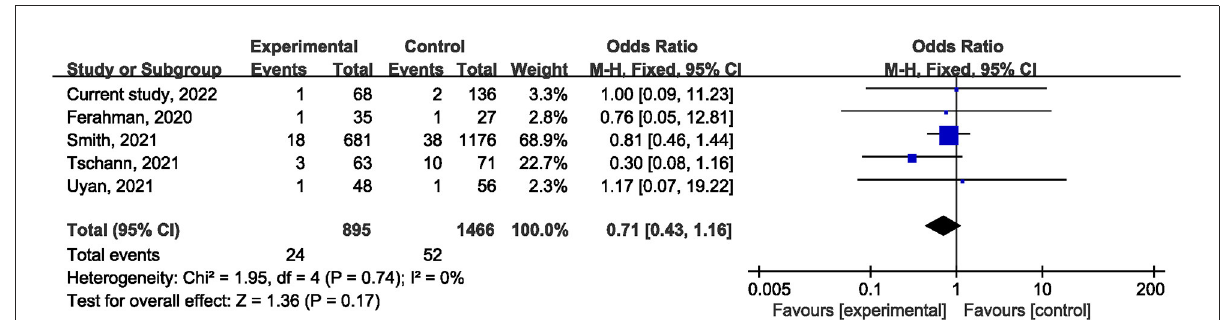
chemotherapy may further impair the long-term prognosis of patients with colorectal